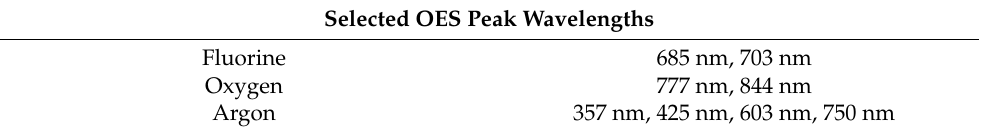
Table 5. Selected optical emission spectroscopy (OES) peak